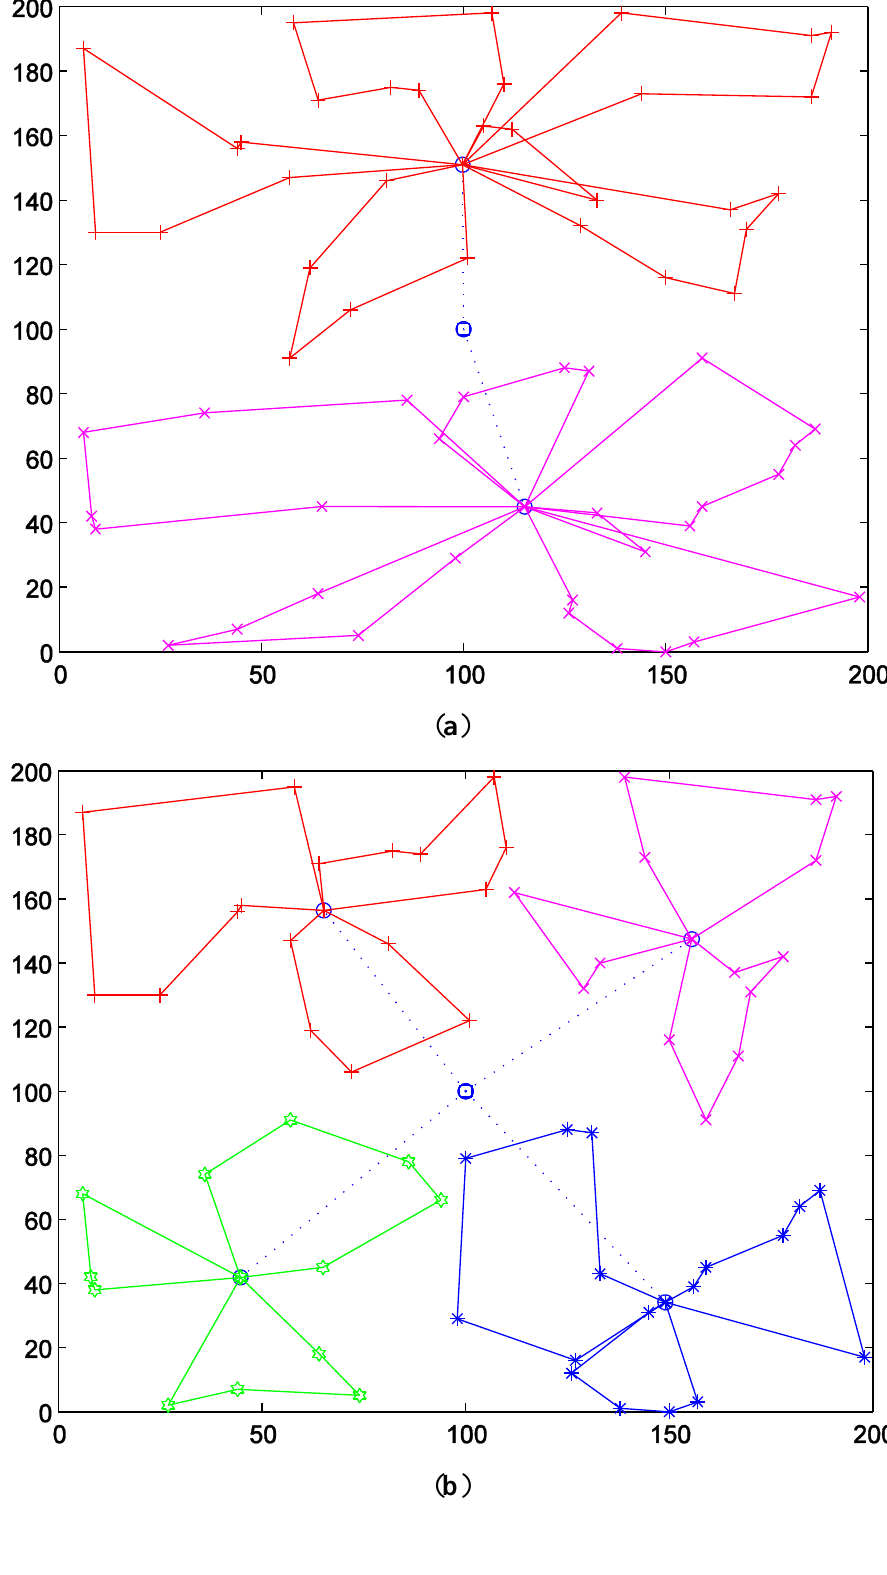
Figure 6. Intermodal transportation routes with two and four TDCs. ( a ) m = 2; ( b ) m =